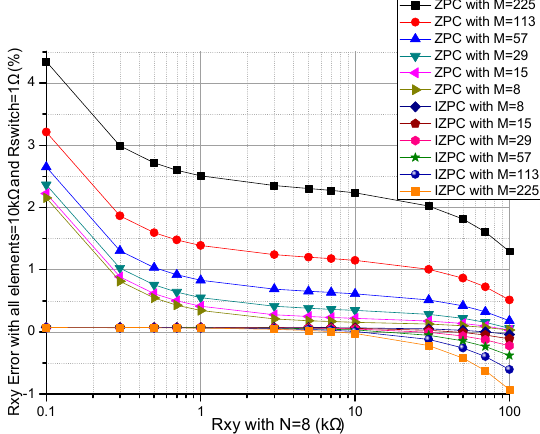
Figure 4. Effect of M on the R xy errors of the basic circuit and those of the improved circuit.